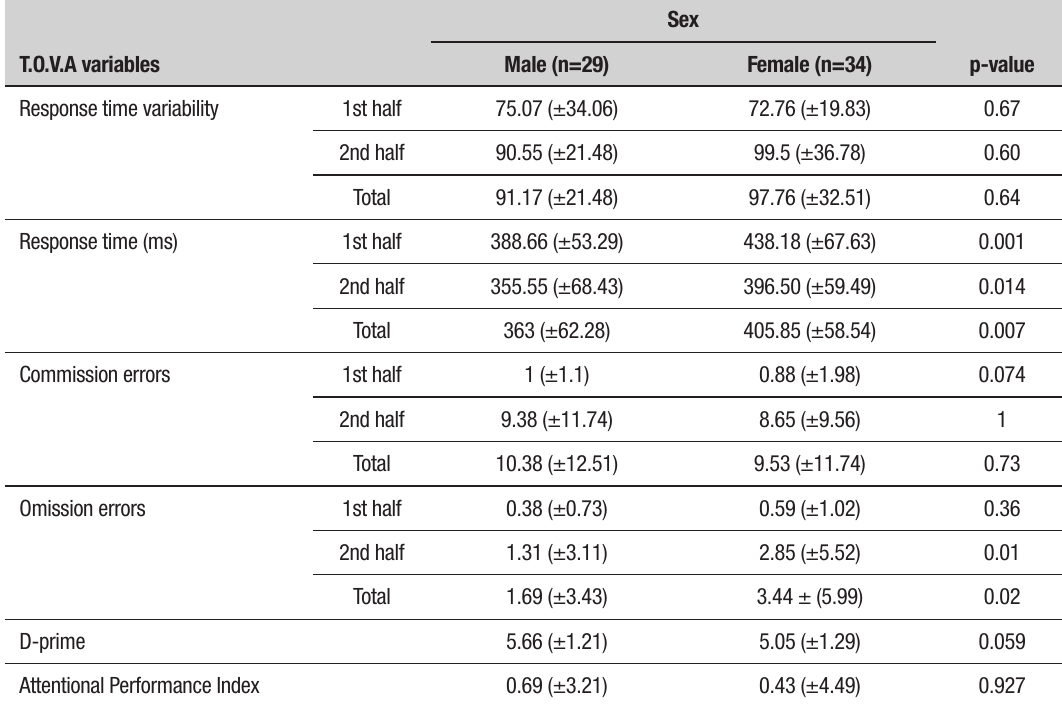
Table 2. Performance on T.O.V.A variables by sex (n=63).